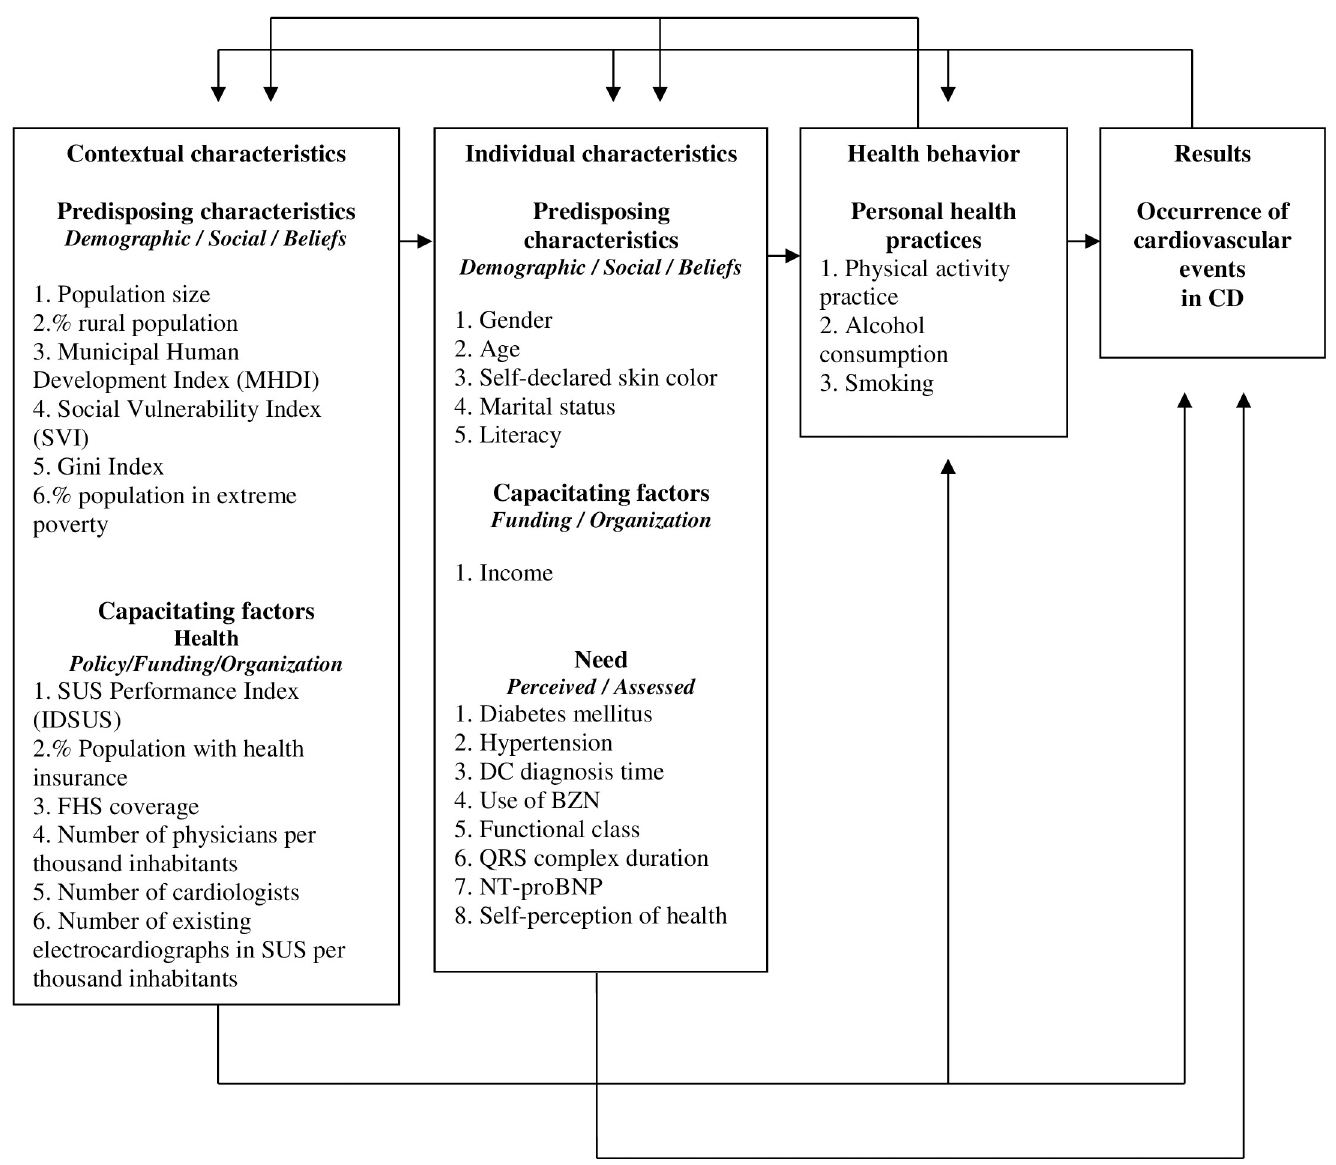
Fig 2. The adopted behavioral theoretical